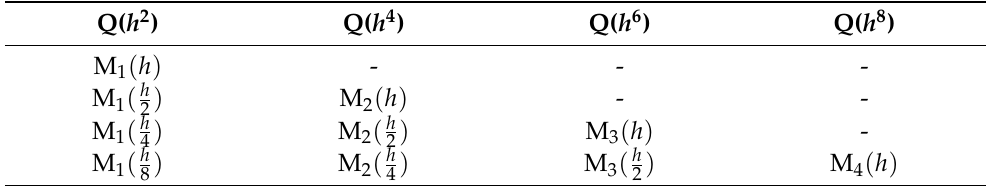
Table 1. The 4th order approximation of Richardson’s